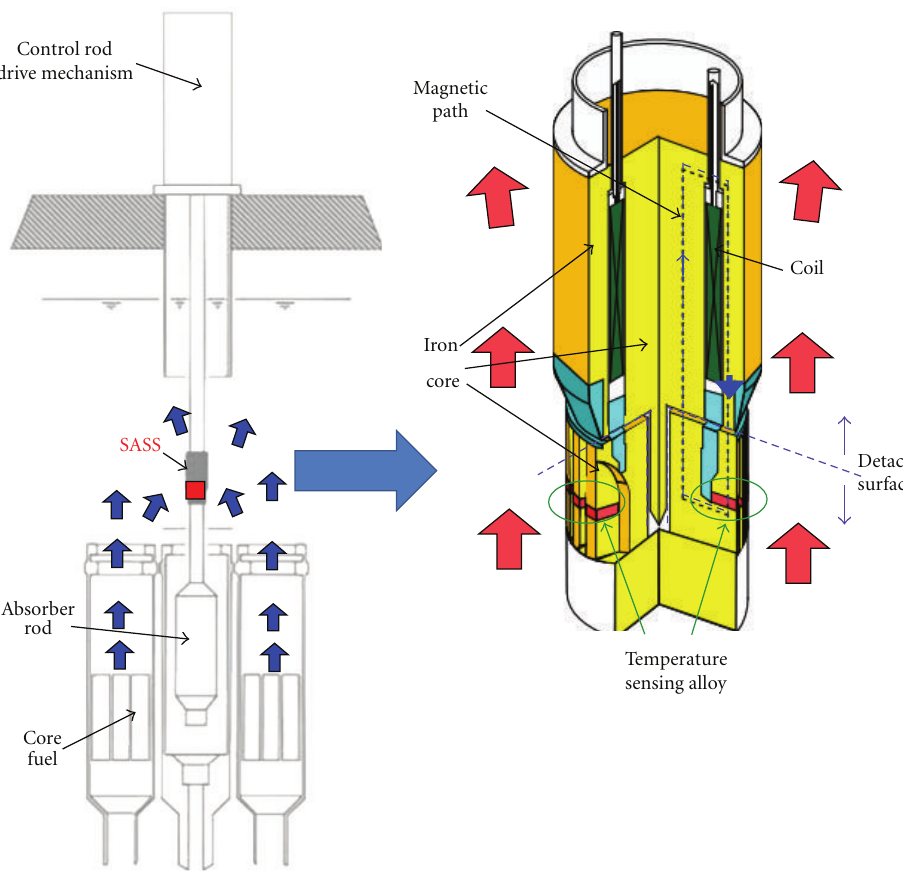
Figure 2: Schematic diagram of the SASS